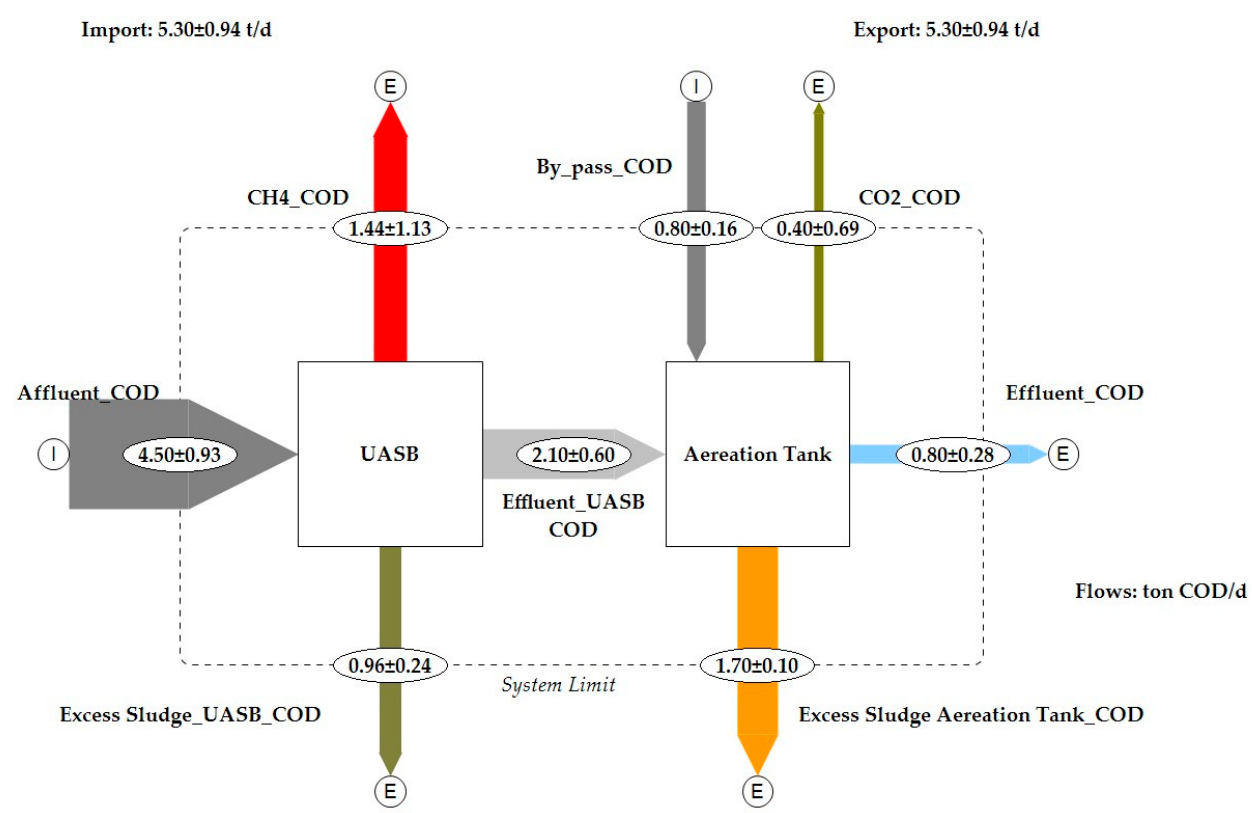
Figure 8. Steady-state COD balance in the Tunja STP.